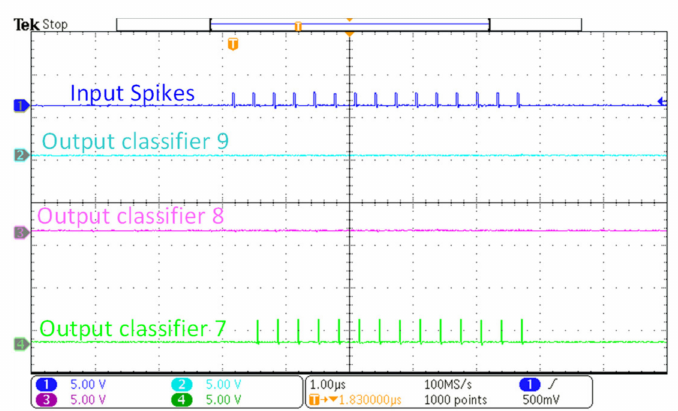
Figure 13. The measured results on the oscilloscope for the analog SNN. The applied input image to the SNN is ‘7’ and the 7th output classifier shows maximum spiking